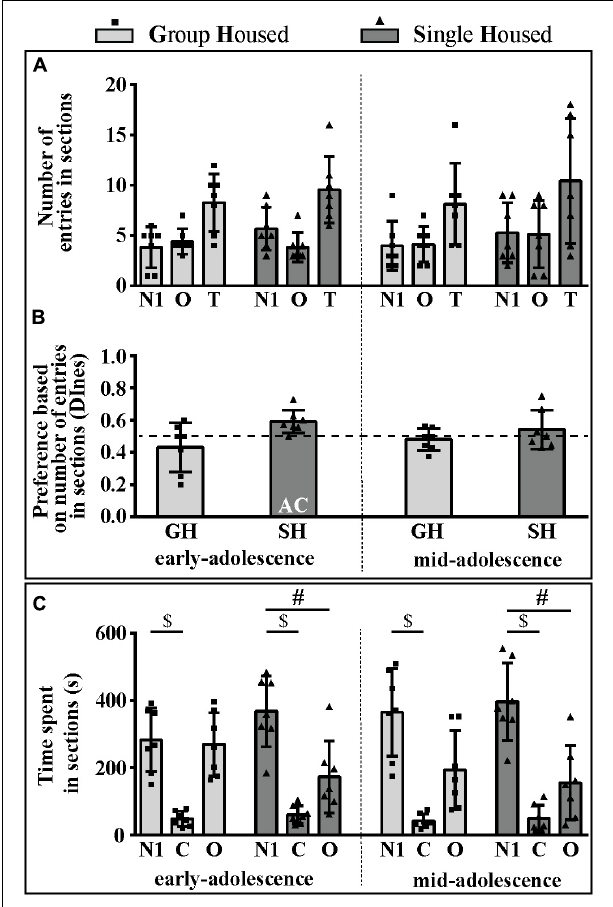
FIGURE 3 | The social orientation of peripubertal male rats in the 3-chamber test at the end of the first week (early-adolescence) and the second week (mid-adolescence) of defined housing, which began on the 29th postnatal day. The data are represented as mean ± SD , with individual data plots along the column bars. (A) The number of entries into compartments with the social stimulus (novel conspecific – N1) and the empty cup (object – O) and the total number of entries (T). (B) Discrimination index based on the number of entries into sections (DInes), addressing “wanting” aspect of the preference for social (N1) section. (C) Time spent in N1 section, O section, and central (C) section, reflecting “liking” aspect of the preference for social (N1) section over other two sections; AC – significantly above the chance level (0.5); $ p ≤ 0.05 (time spent in the N1 section vs. time spent in the C section); # p ≤ 0.05 (time spent in the N1 section vs. time spent in the O section). Statistical comparisons and exact p -values are given as Supplementary Table S1